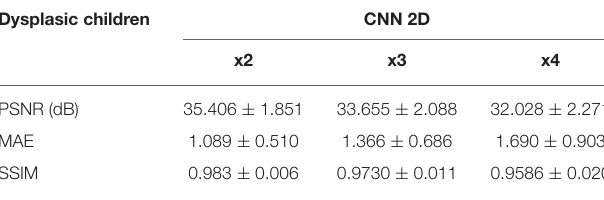
TABLE 6 | Results for different metrics and scaling factors among dysplasic children test set using 2D CNN method.